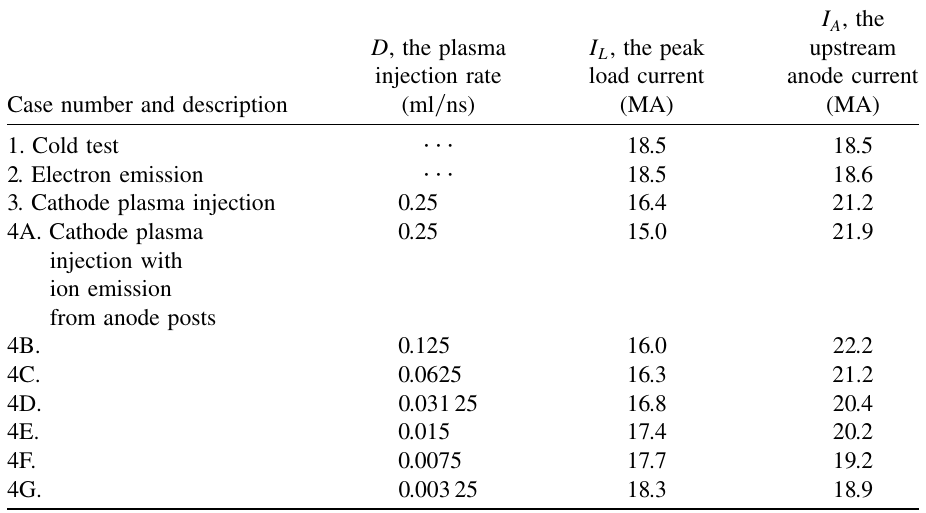
TABLE I. Summary of 3D PIC simulations of the Z DPH giving the approximate peak load current obtained and the approximate total anode current upstream of the convolute region.